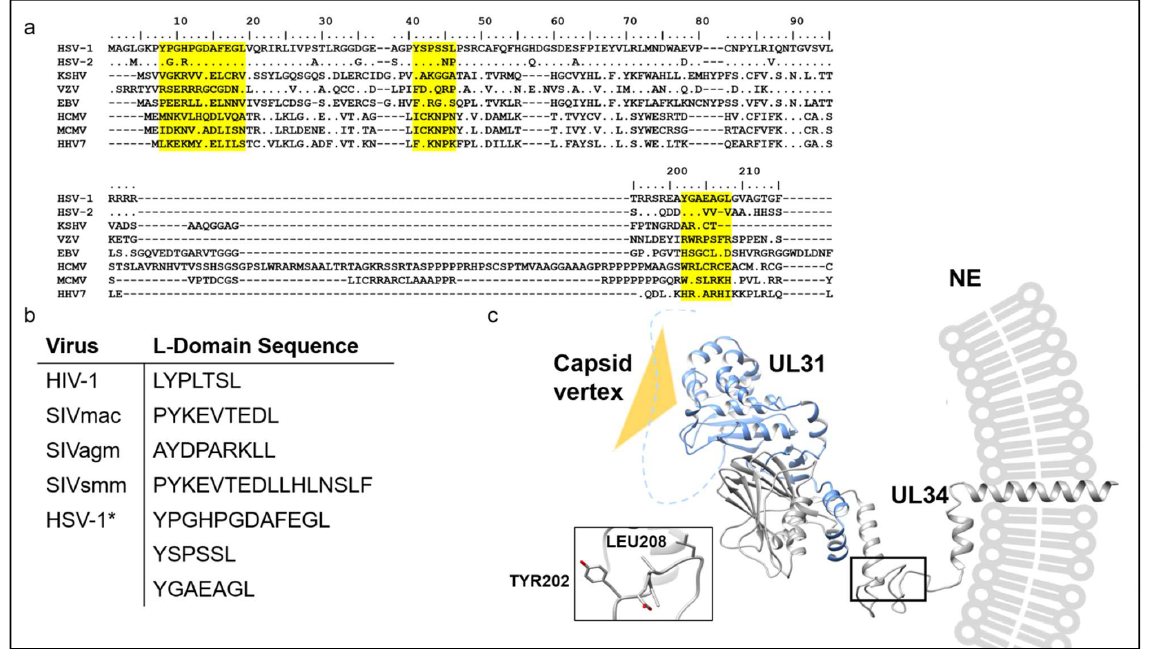
Figure 4. Sequence and structure analysis of HSV-1 UL34 reveals a putative L-Domain-like sequence that may promote its interactions with ALIX. ( a ) Sequence alignment of the HSV-1 NEC complex component UL34 across herpesvirus families. Putative L-Domain residues seen in HSV-1 are highlighted in yellow. ( b ) Sequence comparison between previously identified L-Domains with those identified from the sequence analysis herein (marked with an asterisk). ( c ) Molecular modeling of the membrane-bound NEC complex from HSV-1. The presence of a potential ALIX binding site located on a flexible inter-domain linker is shown boxed and with an inset. This linker region within UL34 contains a tyrosine residue (TYR202) that extends outward and away from the rest of the protein. At the edges of the NEC hexagonal assembly, these flexible loops could be exposed to mediate recruitment of ALIX to sites of nuclear egress.